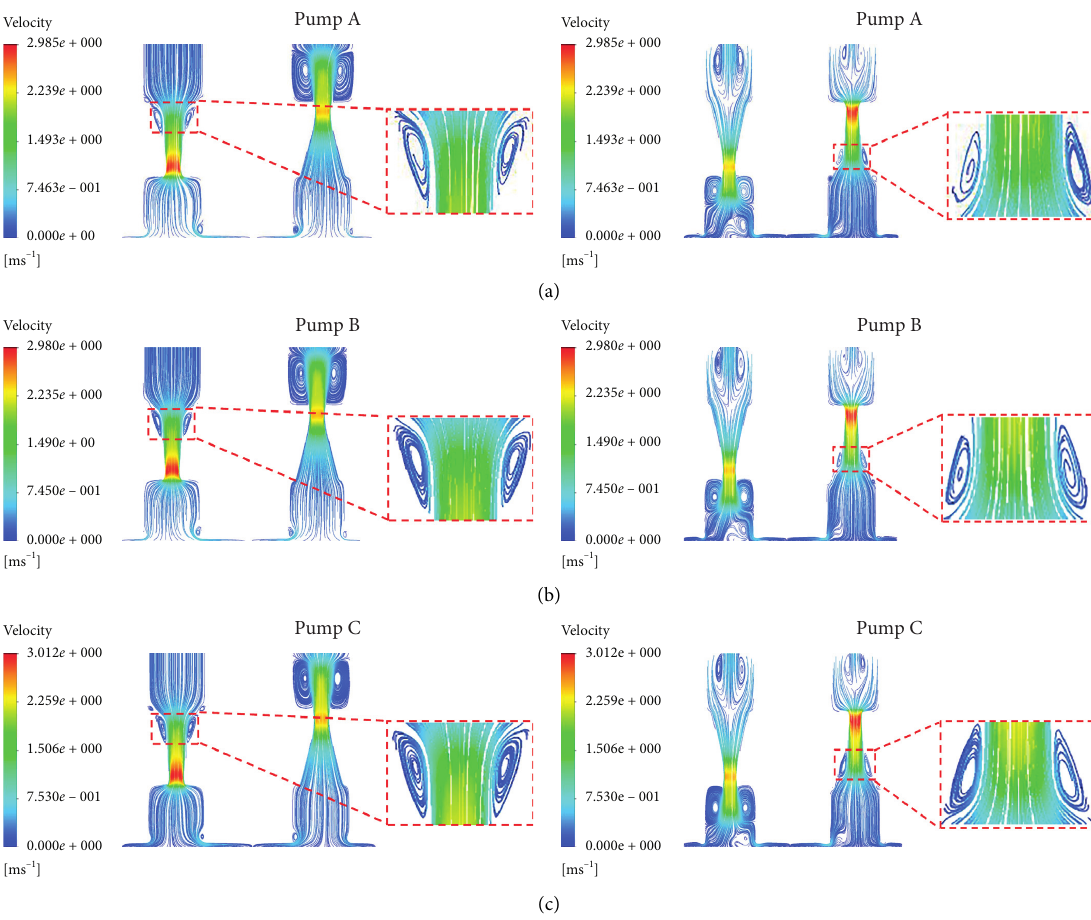
Figure 4: The velocity streamline diagrams of these pumps in different stages: (a) the schedule stage; (b) the suction